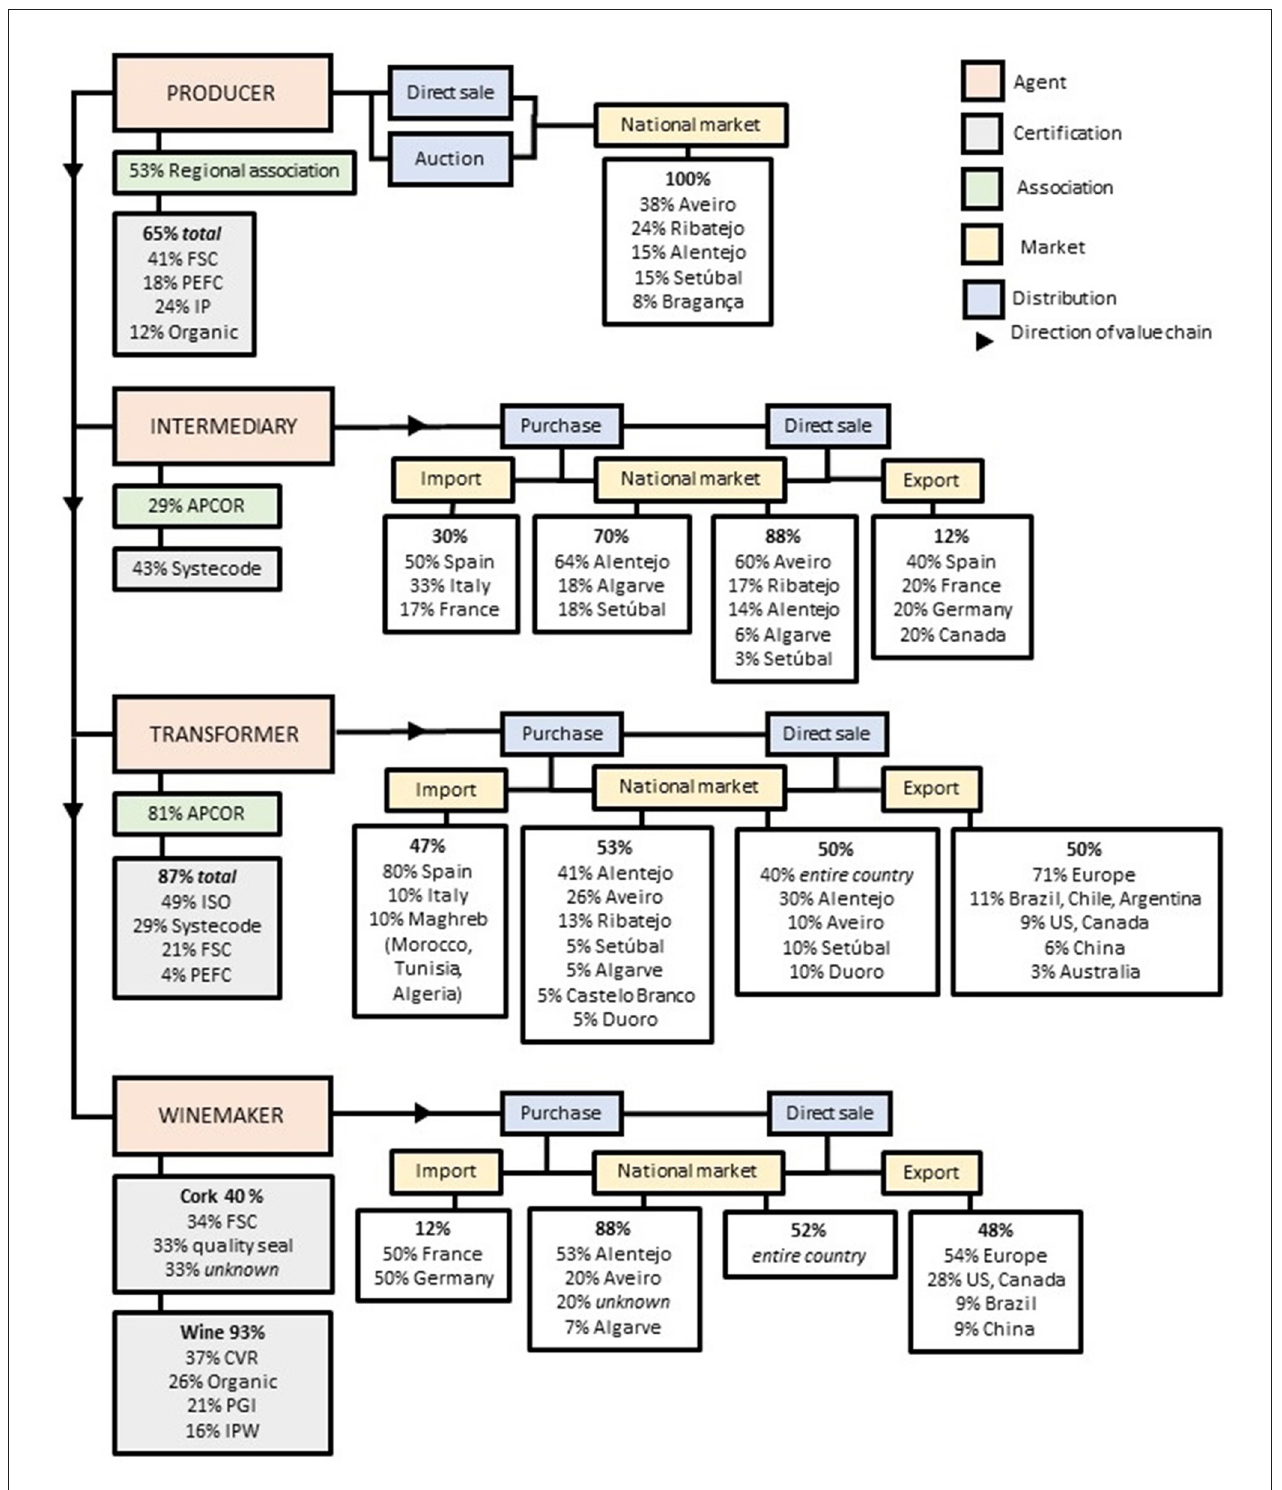
FIGURE 7 | Flow chart displaying the cork value chain including agents and sub-actors (certification bodies and associations) and distribution and marketing channels. Abbreviations are described in the main text. Association and certification: The proportions indicate the total members amongst our respondents. Purchase and sale: Proportions in bold represent the division of market type. The proportions below represent the frequency of place names of the respective receiver location mentioned by respondents.